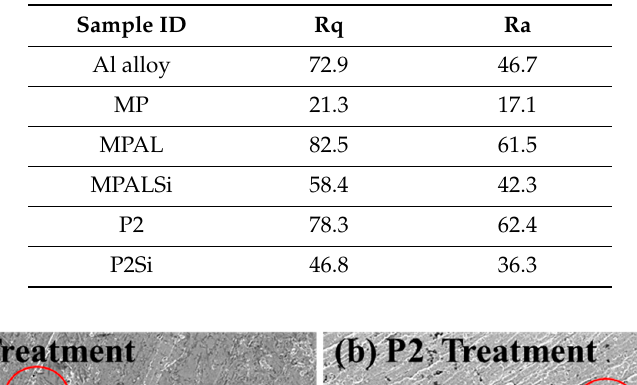
Figure 3. 3D atomic force microscope (AFM) height images of the Al alloy with different surface treatment, ( A1 ) untreated, ( B1 ) mechanical polishing (MP) treated, ( C1 ) Mechanical polishing and the alkali solution immersion (MPAL) treated, ( D1 ) Mechanical polishing, alkali solution immersion, and the silane coupling agent surface (MPALSi) treated, ( E1 ) P2 etching (P2) treated and ( F1 ) P2 etching and silane coupling agent surface (P2Si) treated Al alloy. Table 3. The roughness data of the di ff erent surface modified Al alloy sheets obtained using an atomic force microscope (AFM).